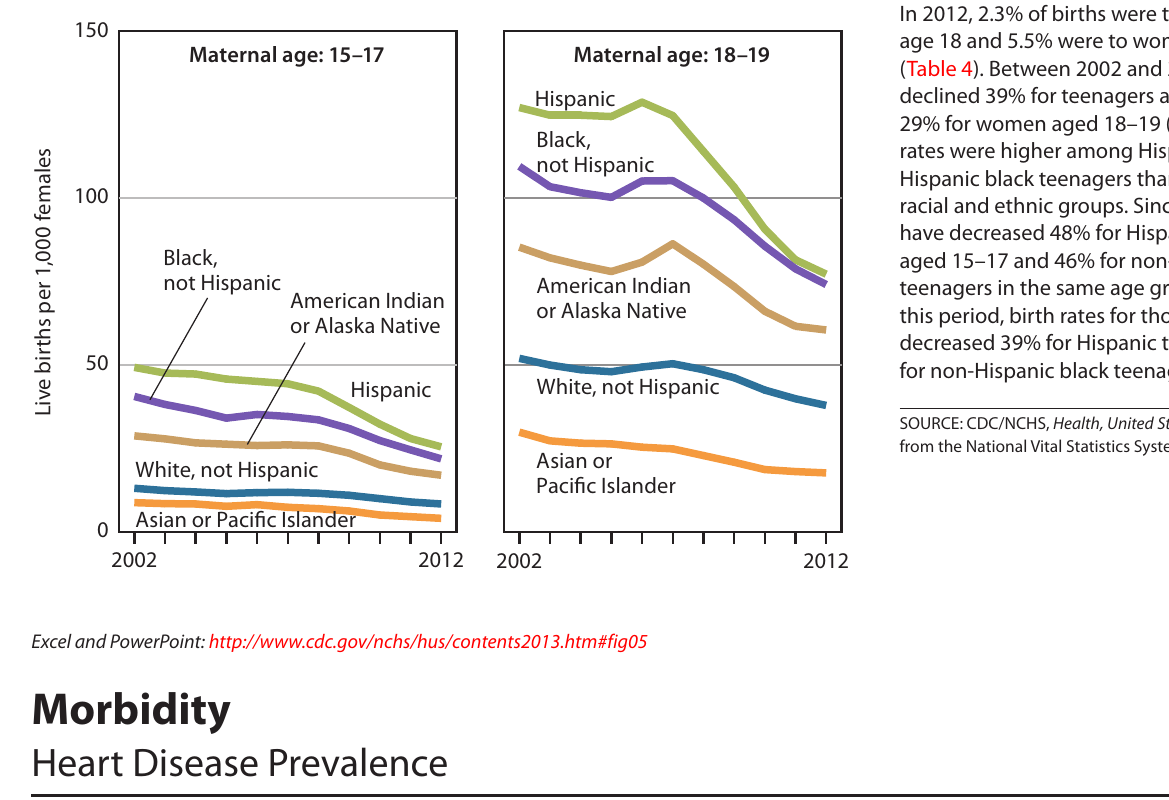
Figure 6. Respondent-reported heart disease prevalence among adults